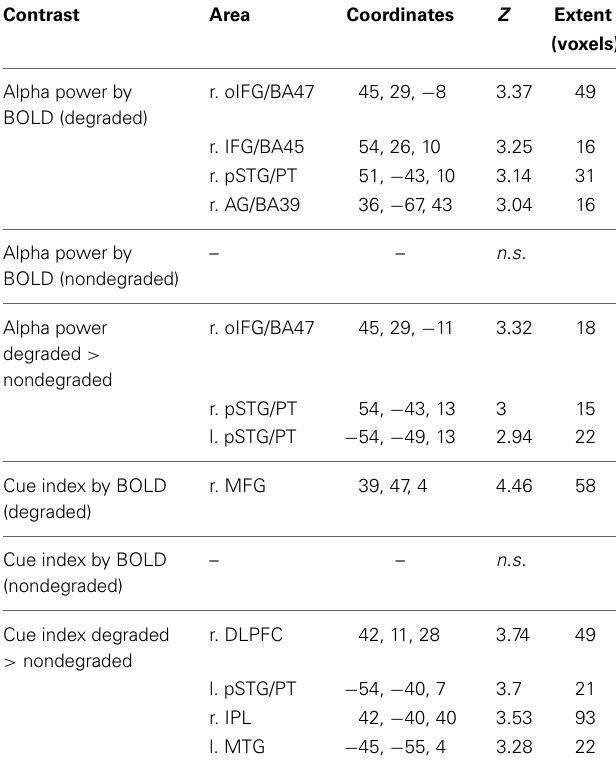
Table 3 | Significant clusters obtained from whole-brain analyses ( p < 0 . 005, extent threshold = 15) for the parametric modulators alpha and cue index, together with modulation differences between